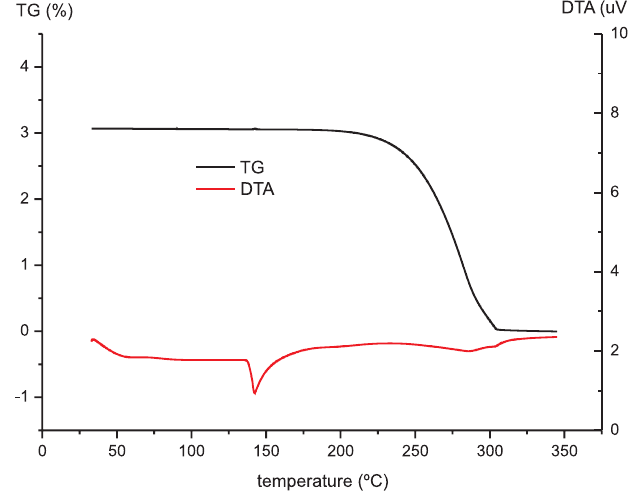
FIGURE 2 - Representative TG/DTA of praziquantel.